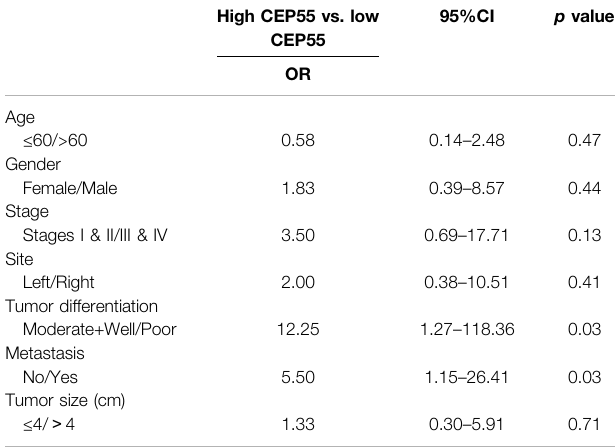
TABLE 7 | The Odds ratio of high/low CEP55 expression in Fn-infected CRC